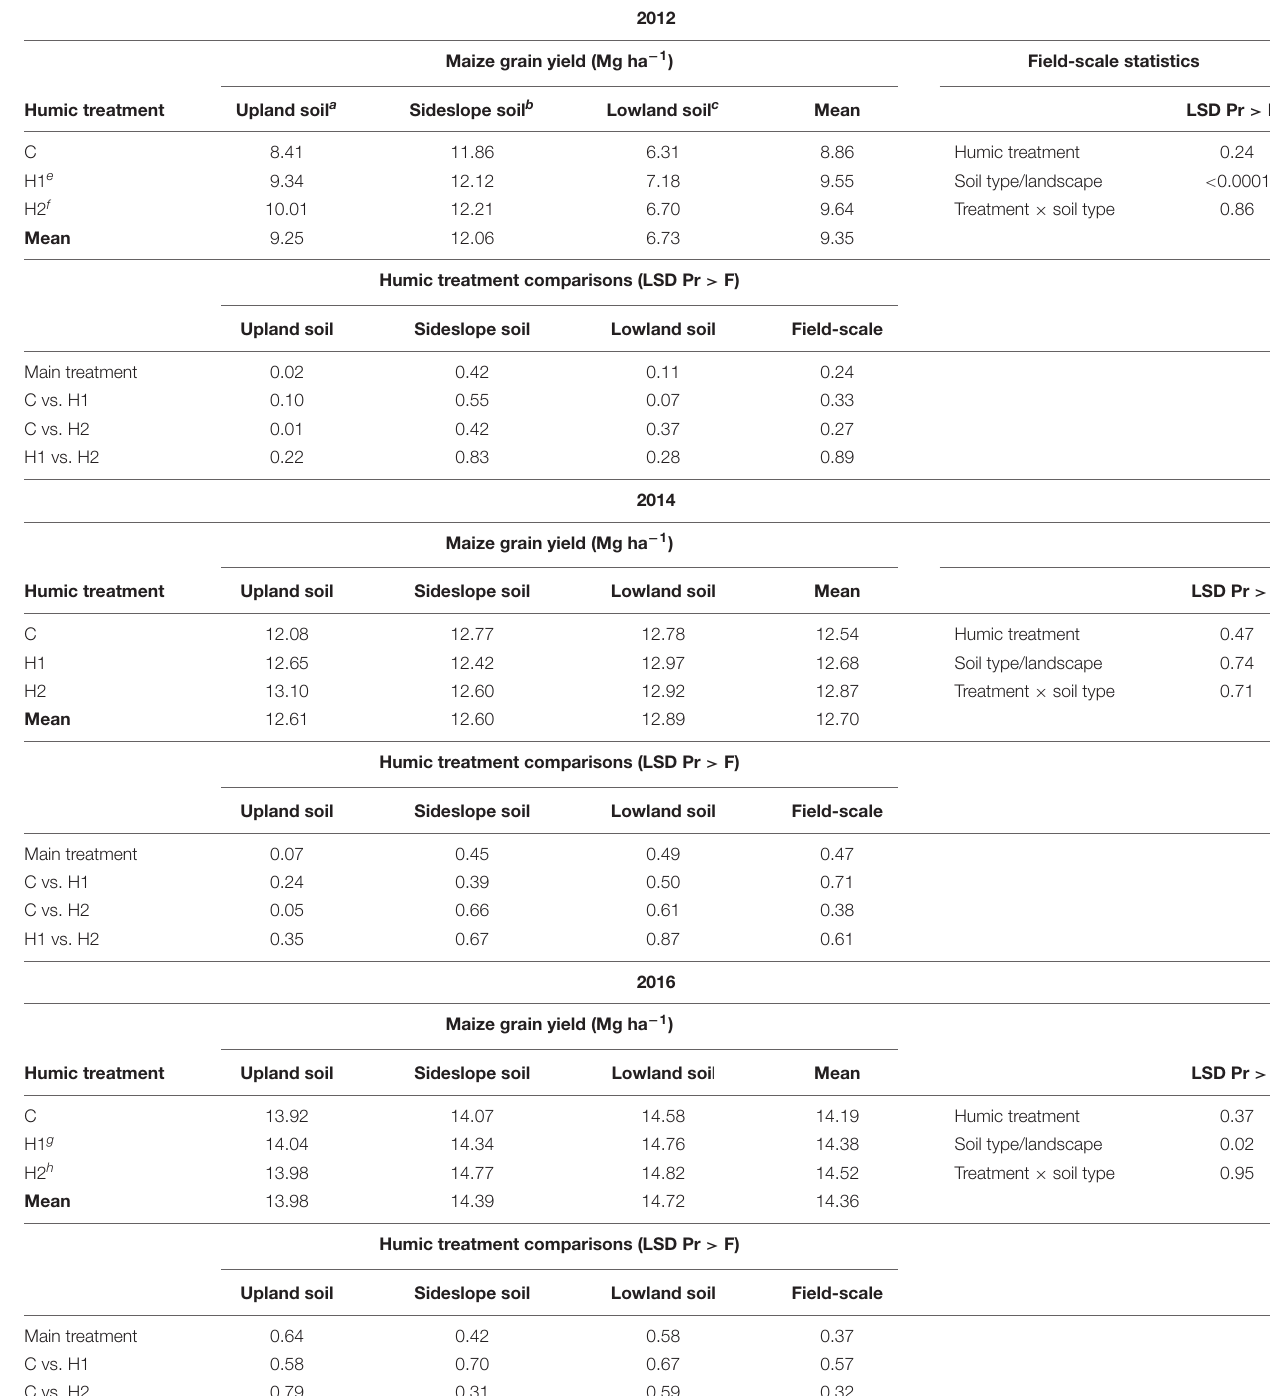
TABLE 2 | Humic product maize grain yield responses to humic product application for the Ames on-farm field trial extracted as georeferenced data from combine yield maps and shown by year (2012, 2014 and 2016) and three soil type/landscape positions. Two rates of humic product application (H1 and H2) were compared to an unamended control